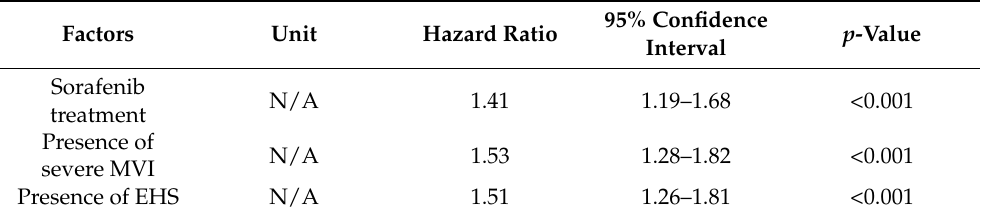
Table 2. Factors Associated With Poor Prognosis After Propensity Score